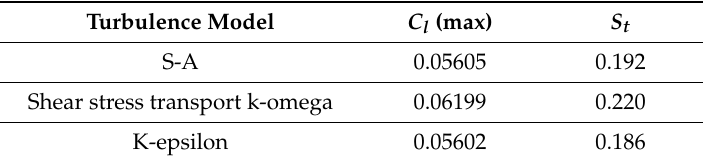
Table 3. Comparison of C l and S t obtained by di ff erent turbulence